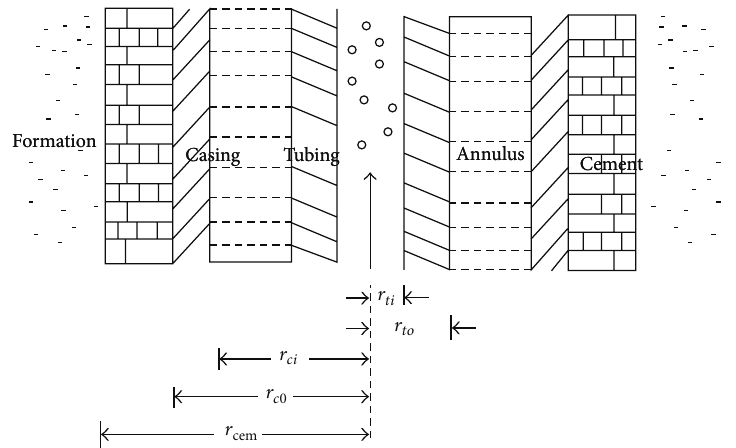
Figure 5: The radial transfer of